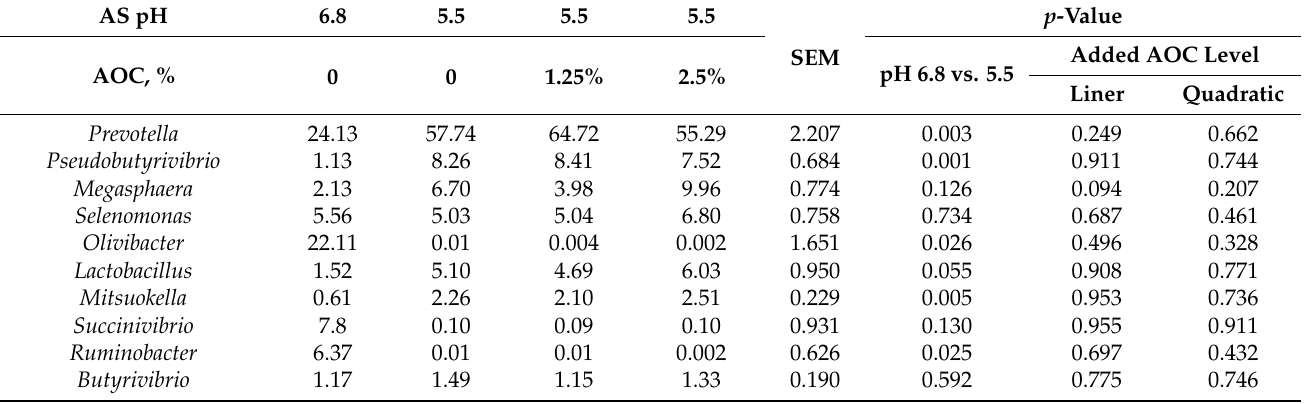
Table 7. The effect of AS pH and supplementation of AOC on rumen bacteria at the genus in RUSITEC system.